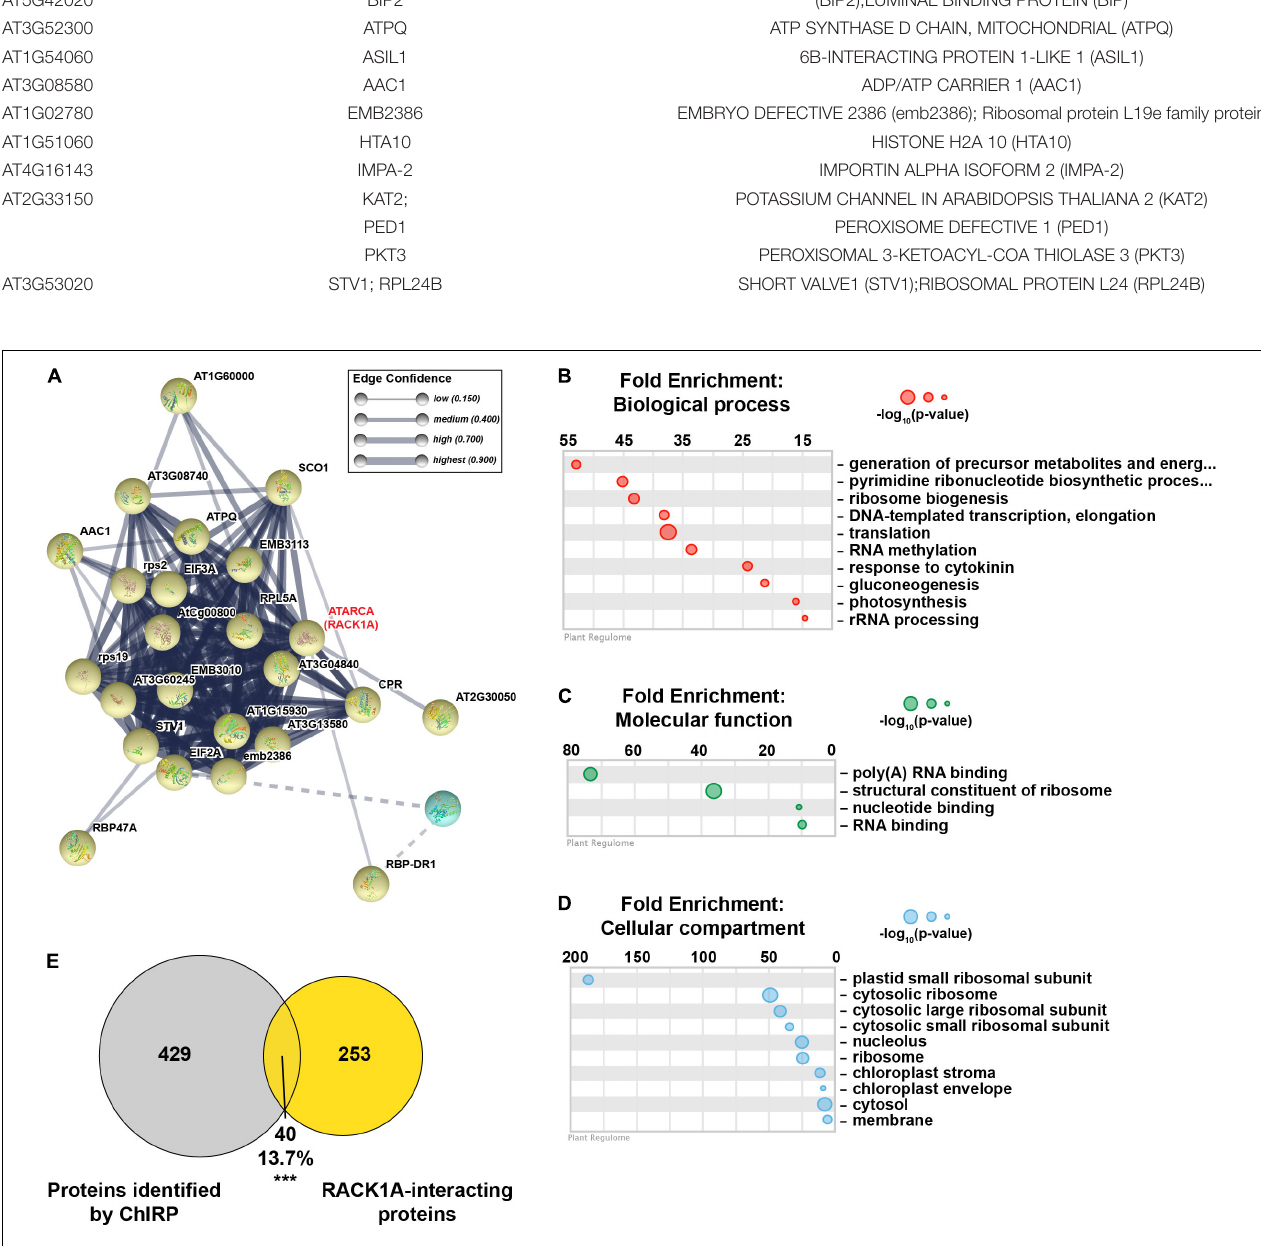
Frontiers in Plant Science |